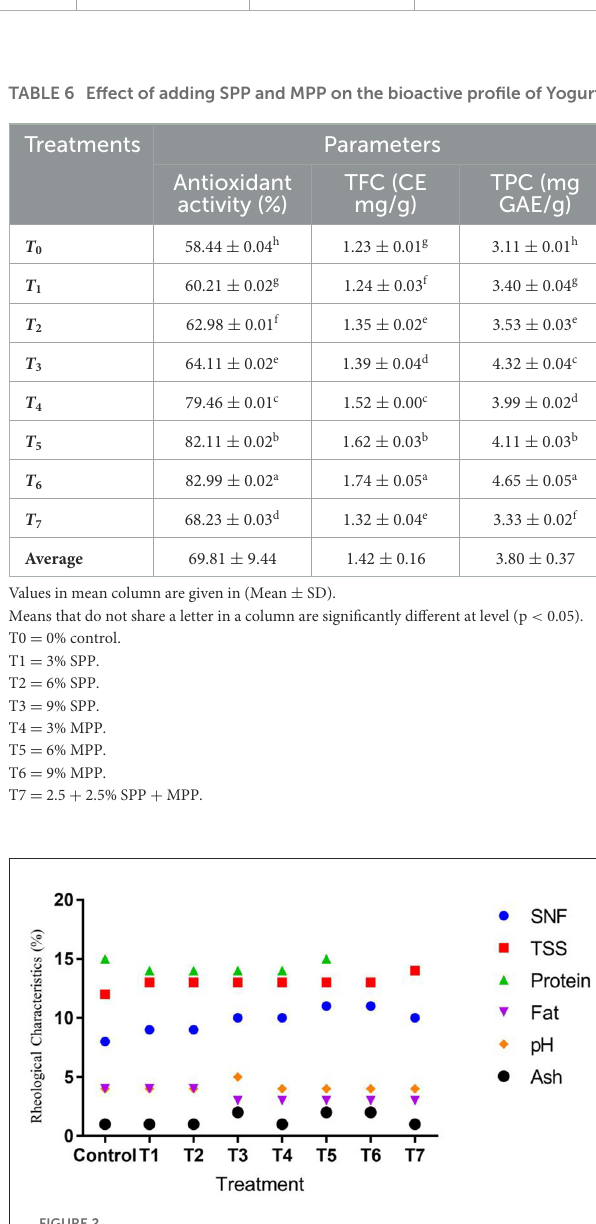
FIGURE2 SPP and MPP effect on biological properties of functional